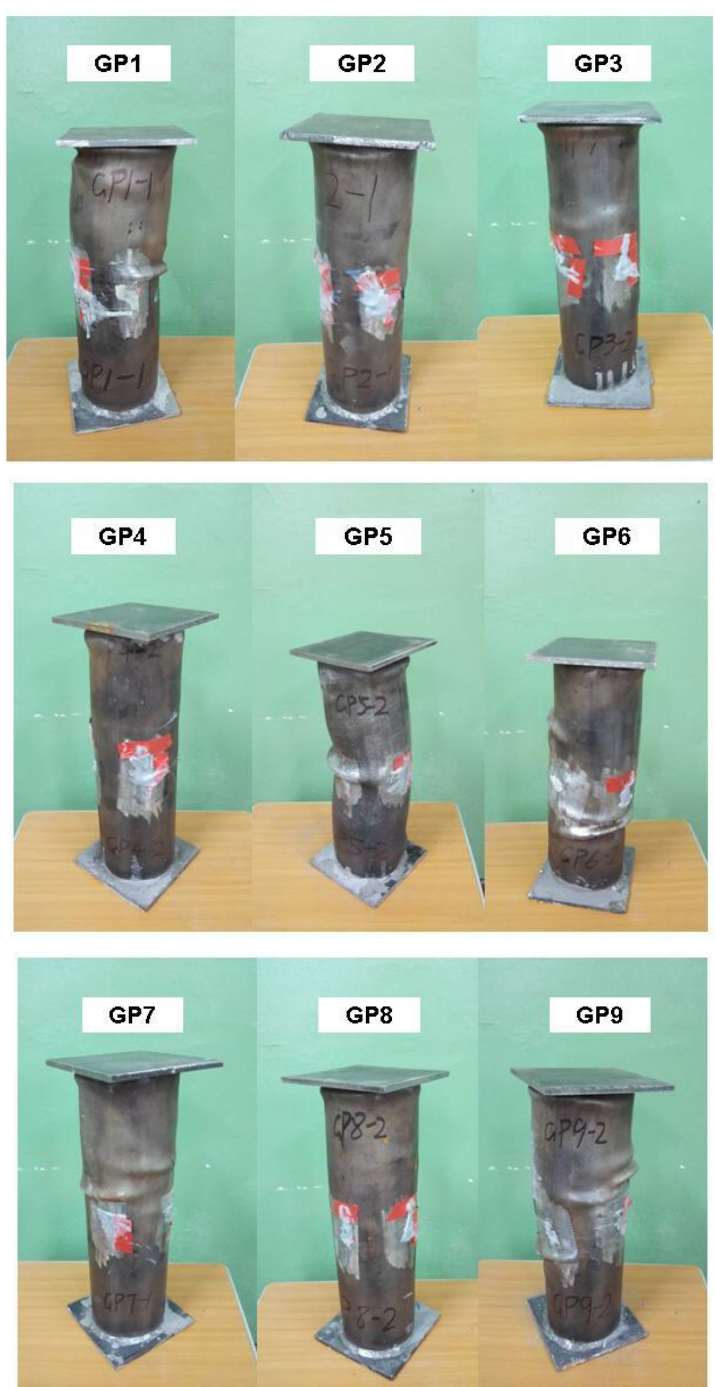
Figure 5. Typical failure form of specimens.